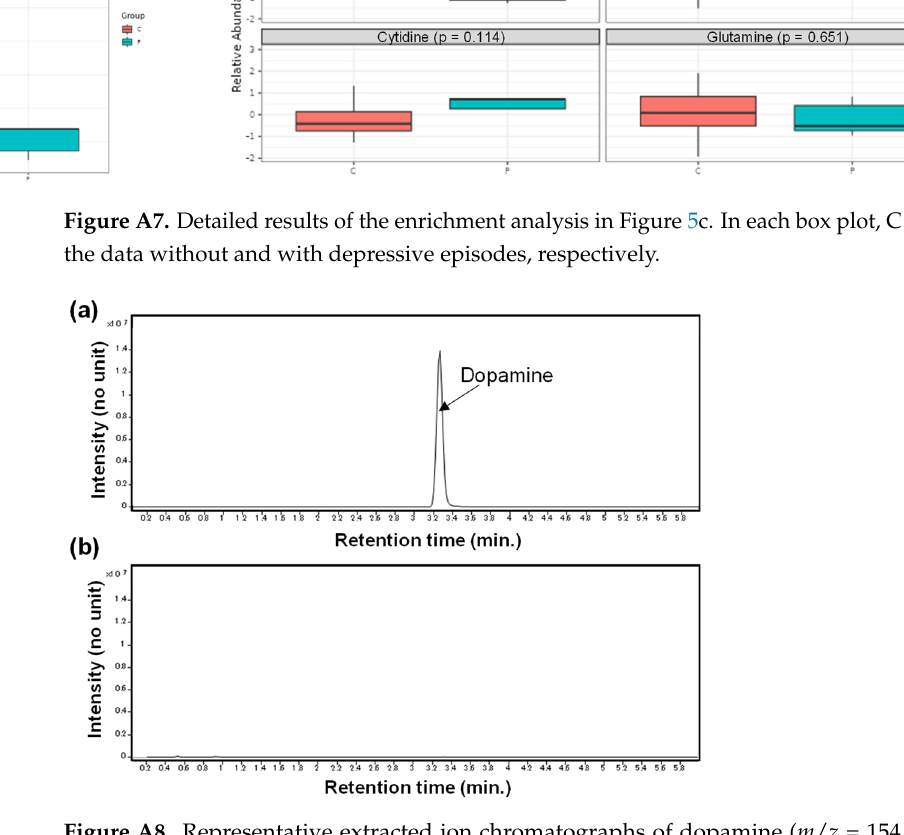
Figure A8. Representative extracted ion chromatographs of dopamine ( m / z = 154.0863, positive mode). ( A ) Standard mixture. ( B ) Urinary sample.